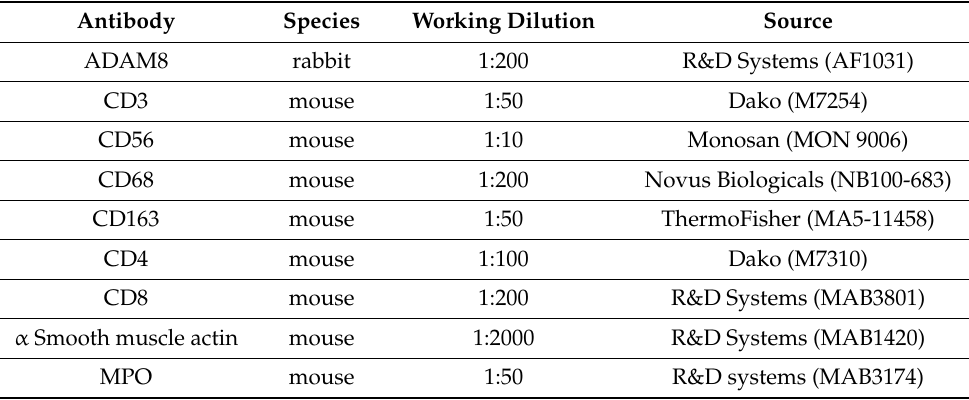
Table 2. Concentrations and sources of primary